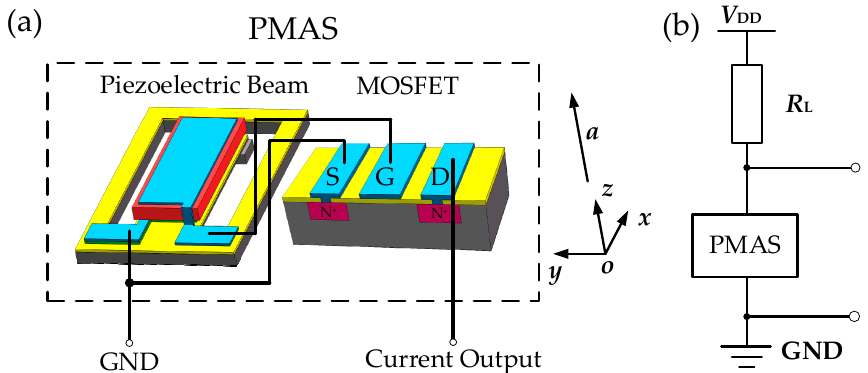
Figure 1. Basic structure and test circuit of piezoelectric metal oxide semiconductor field effect transistor (MOSFET) acceleration sensor (PMAS): ( a ) basic structure; ( b ) test circuit.